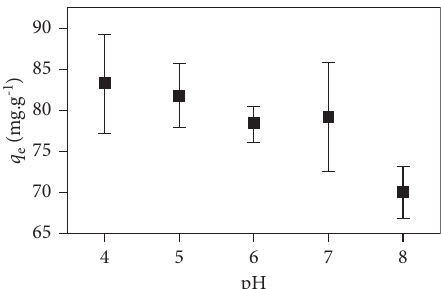
Figure 2: The effect of pH in water for chromium (VI) adsorption onto Cu